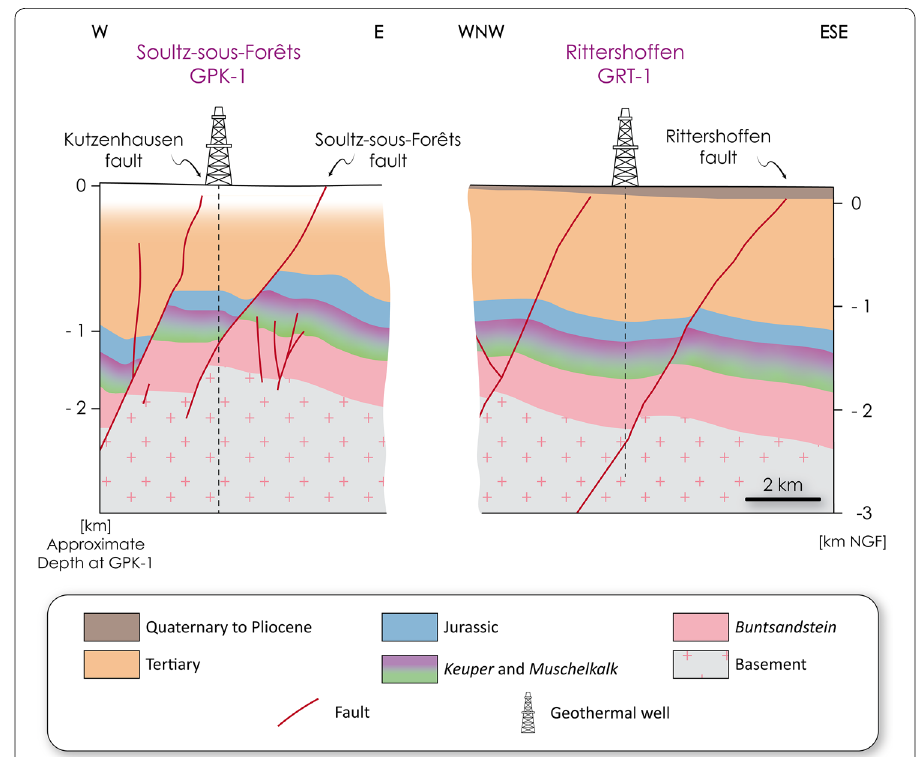
Fig. 13 Geological cross-sections at the Soultz-sous-Forêts and Rittershoffen geothermal sites. Location of the wells and interpretative trajectory of GRT-1 are indicated. GRT-1 crosses the major Rittershoffen fault only in the basement. The Kutzenhausen fault and the Soultz-sous-Forêts fault are intersected by both GPK-1 and 2. This fault causes a significant displacement of the formations and brings side by side the Tertiary and Jurassic sediments near the Soultz wells. Soultz-sous-Forêts cross-section modified after interpreted 2D seismic by Place et al. (2010). Rittershoffen cross-section modified after Équipe du projet GeORG